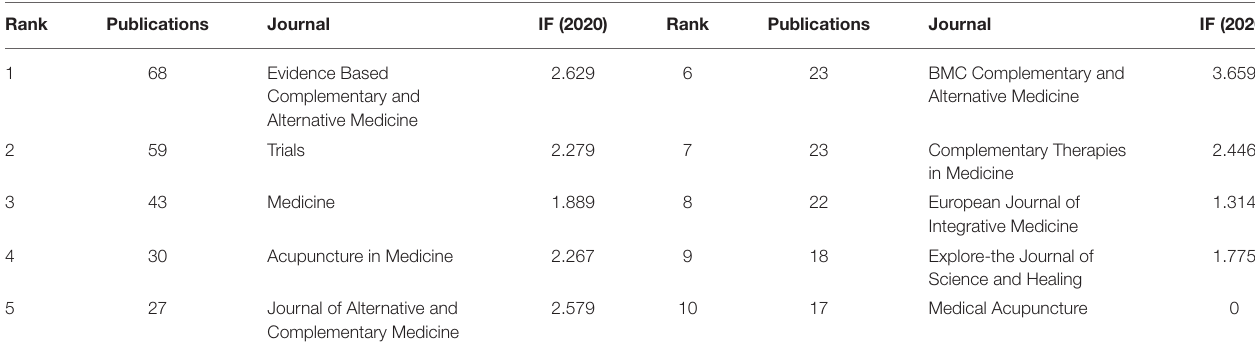
TABLE 1 | Top 10 scholarly journals related to acupuncture on